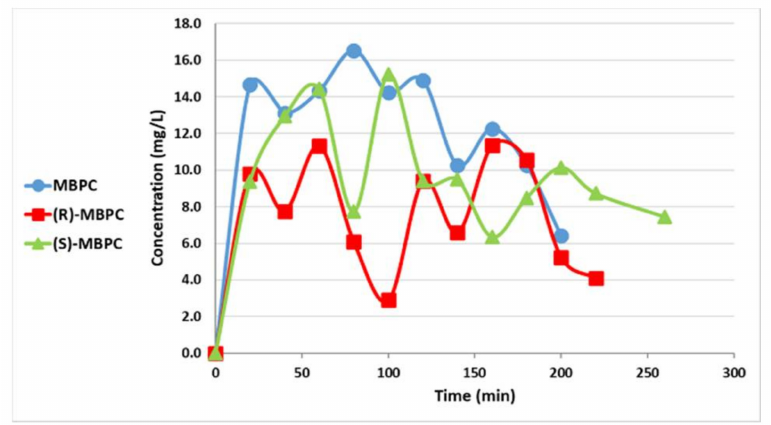
Figure 3. Brain concentrations of 3-methylpropyl(4-sulfamoylphenyl)carbamate (MBPC) (racemate), (R)-MBPC, and (S)-MBPC after i.p. (80 mg/kg) administration to rats. The rat-MES (p.o.) ED 50 and TD 50 values (and their 95% confidence interval—95% CI) of racemic-MBPC, (S)-MBPC, and (R)-MBPC in comparison to MSPC and its individual enantiomers, as well as their safety margin expressed as protective index (PI = TD 50 /ED 50 ), are depicted in Table 3. Table 3. Quantitative anticonvulsant and minimal neurotoxicity data (ED 50 and TD 50 values) and pro- tective indexes (PI) of 3-methylpropyl(4-sulfamoylphenyl)carbamate (MBPC) and 3-methylpentyl(4- sulfamoylphenyl)carbamate (MSPC). in rats dosed p.o. or i.p. b . MES-ED 50 (mg/kg) Neurotoxicity-TD 50 (mg/kg) Protective Index Cmpd [95% CI] a [95% CI] a (PI = TD 50 /ED 50 ) Racemic-MBPC 25 [17–32] >500